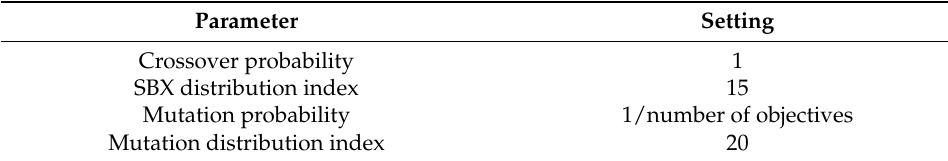
Table 2. Parameter setting for MOSA/D.